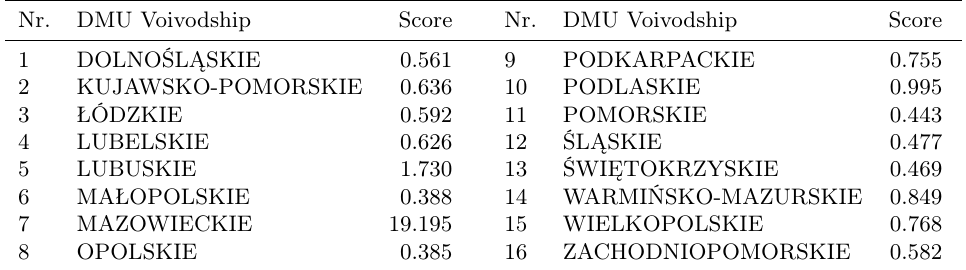
Table 4: SBM-SE scores of 16 NUTS-3 Voivodships of Poland Nr.